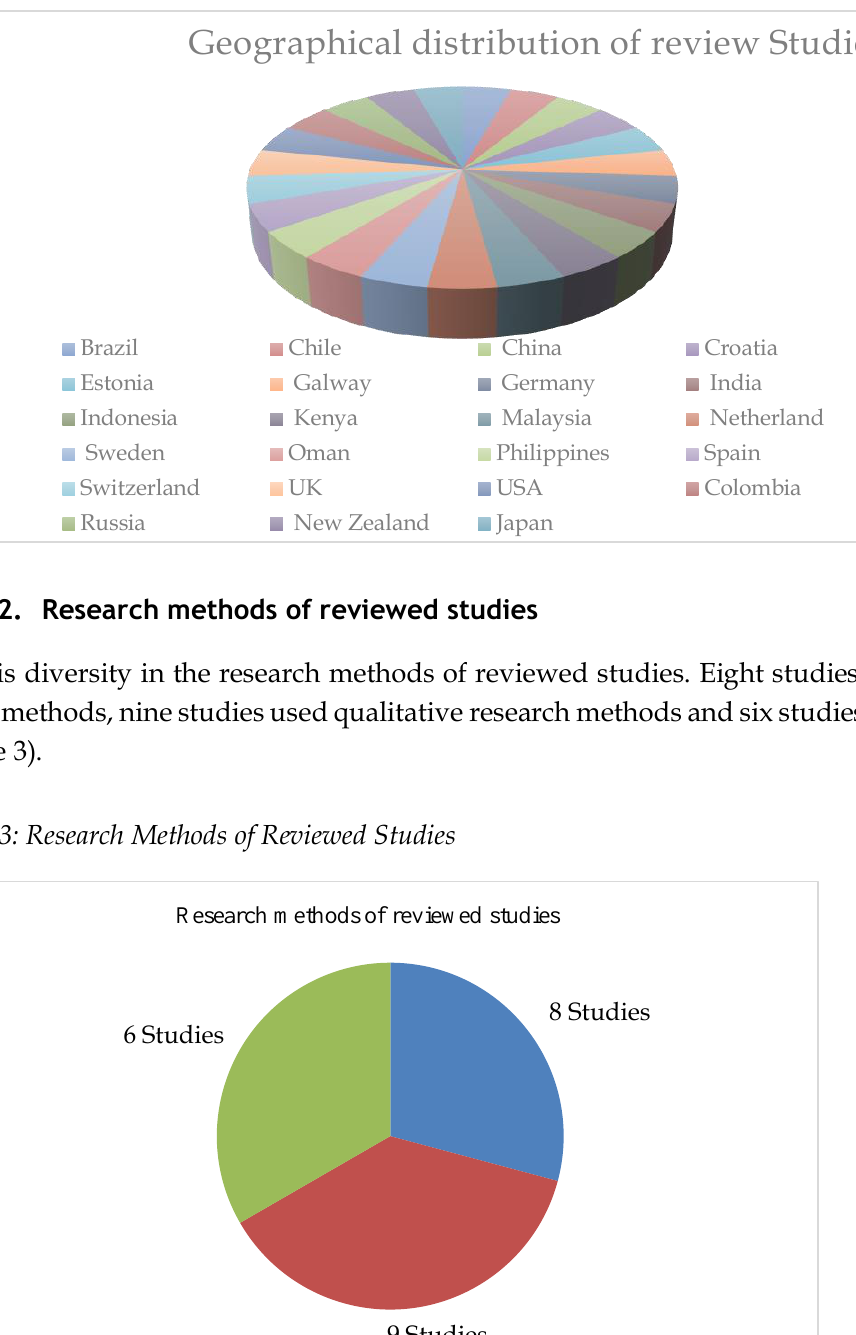
Figure 2: Geographical Distributions of Reviewed Studies